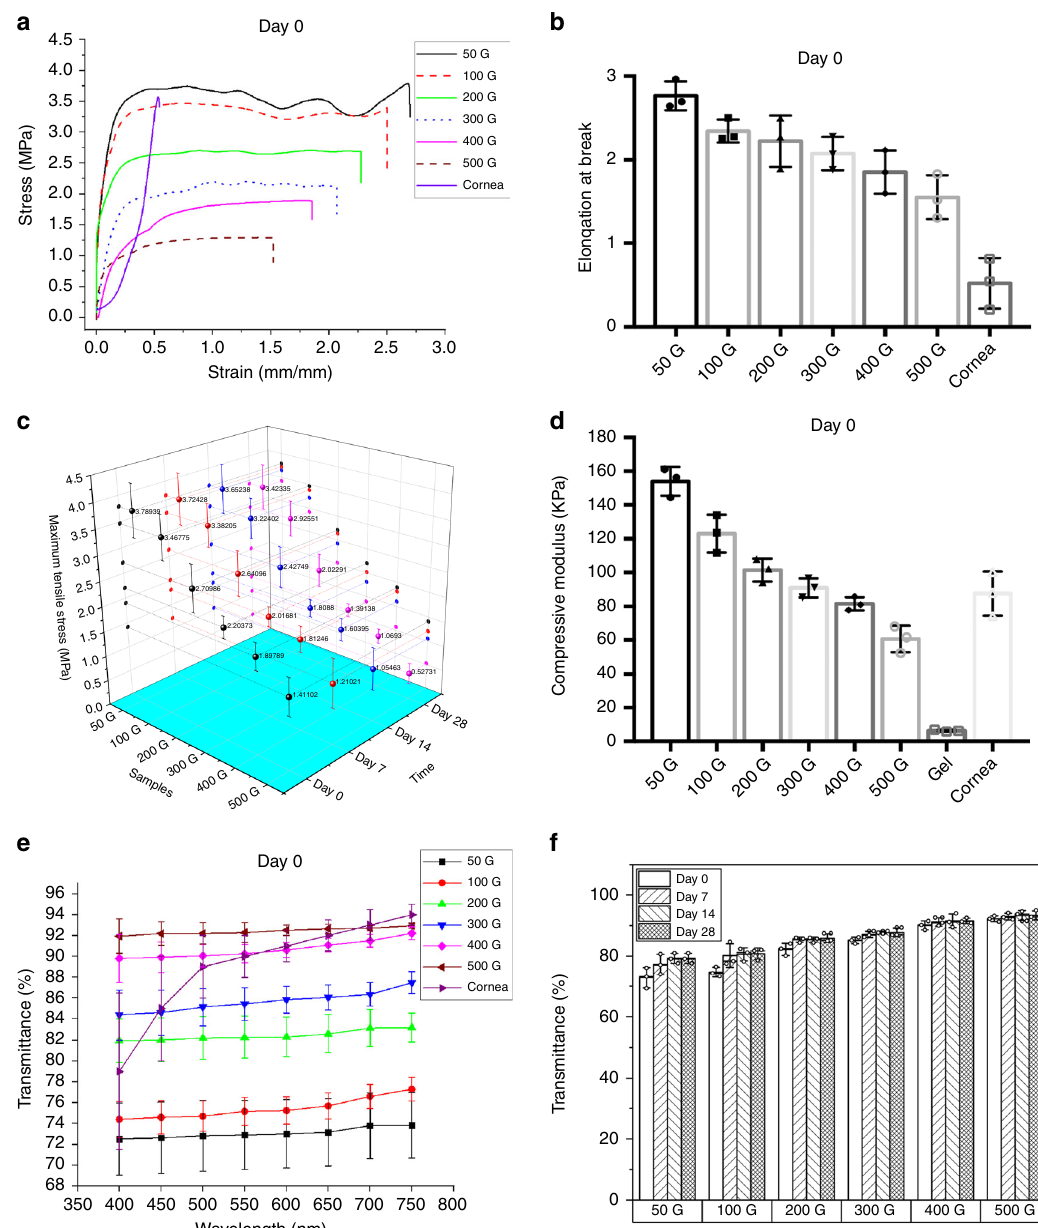
Fig. 2 Fiber hydrogel properties. a Average strain – stress curves of 50G, 100G, 200G, 300G, 400G, and 500G constructs and the acellular cornea after incubating in PBS for 1 h. b Histogram of strain at break of the samples in a . c Maximum tensile stress histogram of the samples in A after incubating in PBS for 0, 7, 14, and 28 days. d Histogram of compressive modulus of 50G, 100G, 200G, 300G, 400G, and 500G constructs, the acellular cornea, and the pure GelMA hydrogel. e The average transmittance spectra of 50G, 100G, 200G, 300G, 400G, and 500G constructs and the acellular cornea after incubating in PBS for 1 h (day 0). f Transmittance histogram of 50G, 100G, 200G, 300G, 400G, and 500G construct after 0, 7, 14, and 28 days of immersion in PBS at the 500 nm wavelengths. All the results were calculated as mean ± standard deviation (SD) ( n = 3, biologically independent samples). Source data are available in the Source Data fi